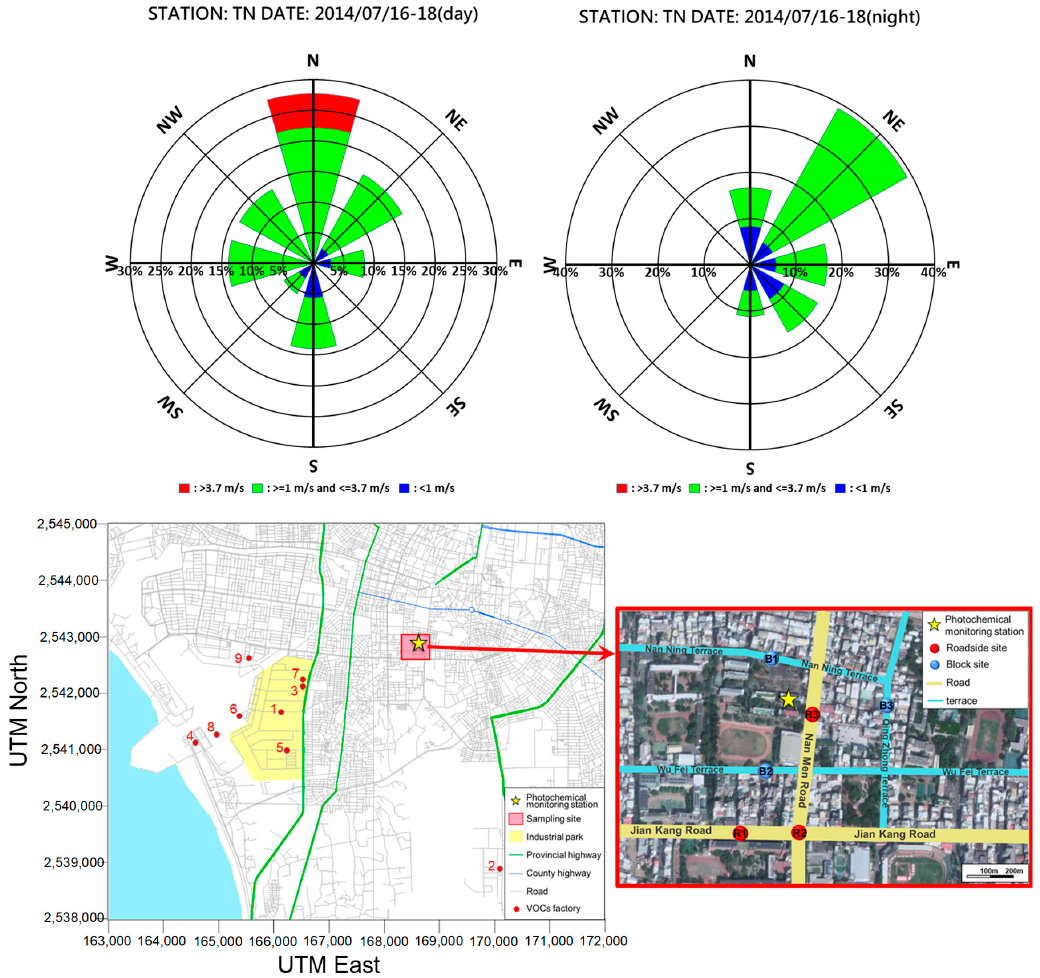
Figure 1. Sampling sites and air pollution emission sources. UTM: Universal Transverse Mercator. The metropolitan area is spread over 2191.6 km 2 and had a population of around 1.88 million people in 2014. Downtown Tainan occupies an area of 175.6 km 2 and in 2014 had a population of 0.78 million people (population density was 4436 people per square kilometer). The population density of the southern district of downtown was 4604 people km − 2 .